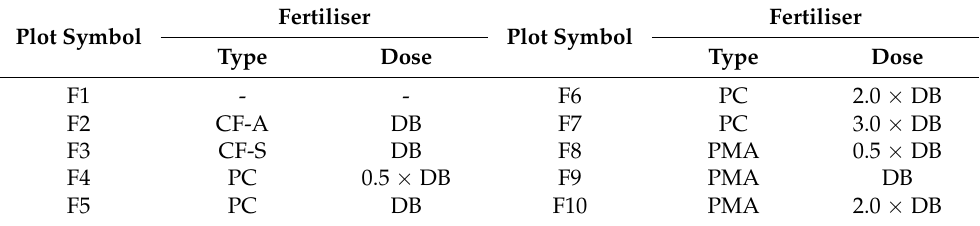
Table 13. Fertiliser dosing in